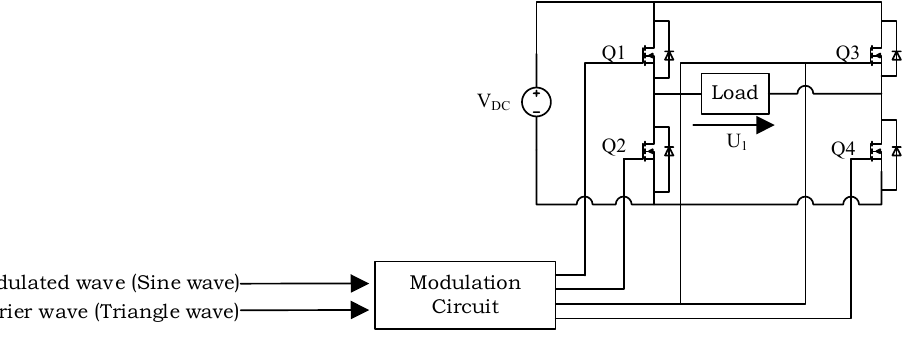
Figure 3. The SPWM single-phase inverter circuit.